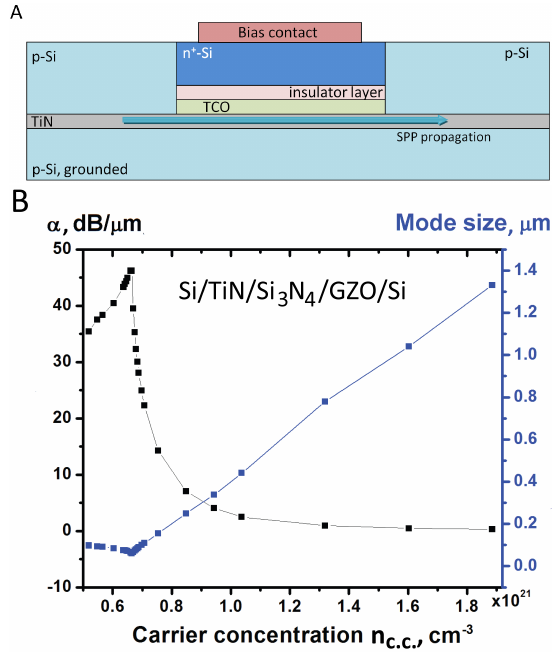
Figure 16: (A) TCO plasmonic modulator along with integration scheme: the input/output interface with low-loss plasmonic strip interconnects. (B) High r = 46 dB/ µ m and small mode size in the range 0.05–1.3 µ m can be achieved [113]. TCO: Transparent con- ducting oxides TCO modulators are similar but include a different number of additional layers, see, for example Refs. [141] and